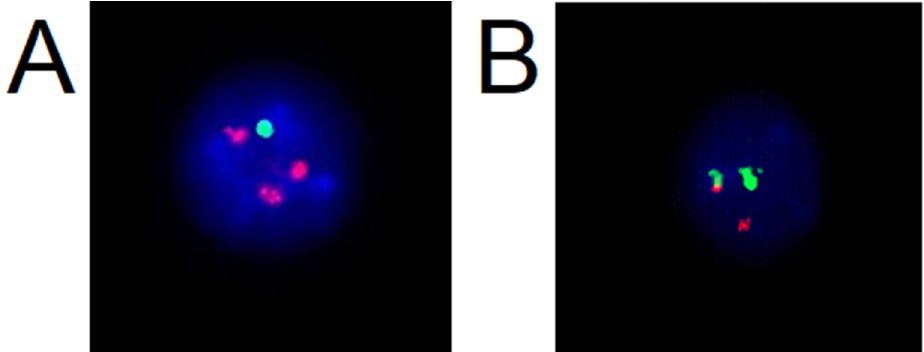
Figure 2. Interphase nuclei with fluorescence numerical probe CDKN2C/CKS1B and break apart probe on 14q32 imaging IGH- Immunoglobulin Heavy Locus Gene: ( A ) aberrant nuclei with deletion in CDKN2C and gains of CKS1B gene, ( B ) aberrant nuclei with chromosome break in IGH locus (source: Author with permission of Medirex laboratory).